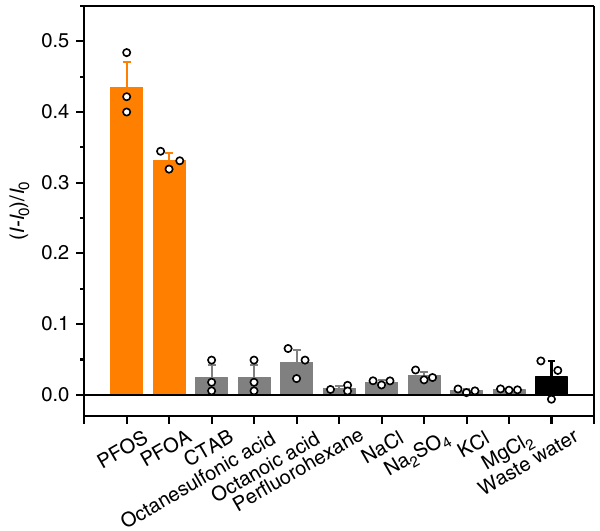
Fig. 5 Selective detection of PFOS and PFOA. Fluorescence responses of GC5A-6C (cid:129) Fl (0.8/1.0 μ M) after adding PFOS, PFOA, and interfering species (0.8 μ M for small species and 5 μ g mL − 1 for waste water samples). I and I fl uorescence of the GC5A-6C (cid:129) Fl reporter pair 0 are the intensities of with and without the guest molecules, respectively. All experiments were performed in HEPES buffer at 25 °C, λ ex = 500 nm, and λ em = 513 nm. The CTAB is hexadecyltrimethylammonium bromide. Error bars represent mean ± s.d. ( n = 3 independent